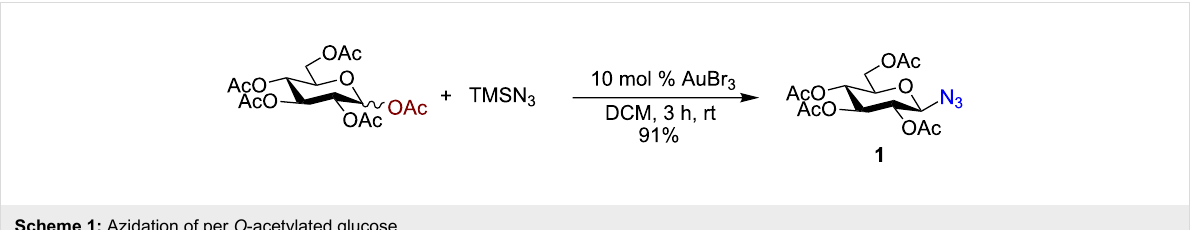
Scheme 1: Azidation of per O -acetylated